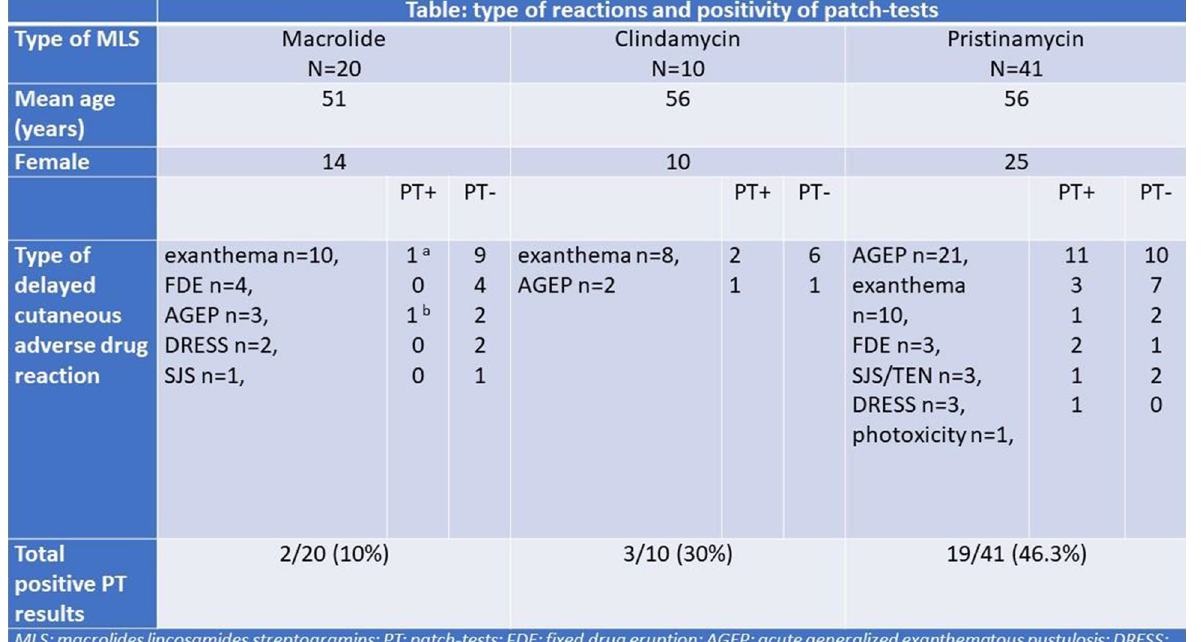
Table 1 Type of reactions and possibility of